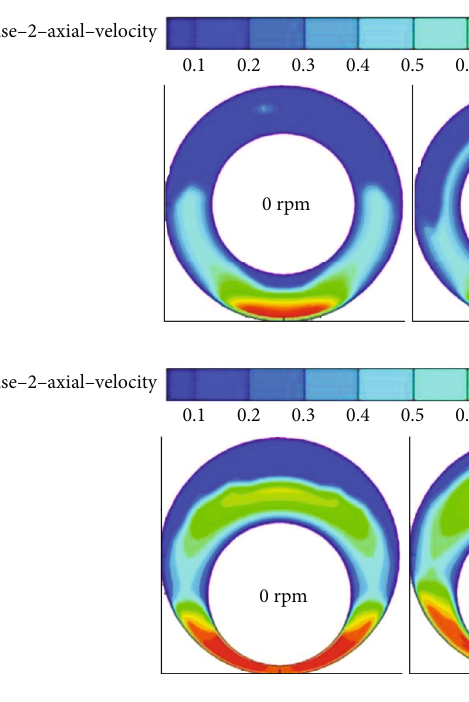
Figure 4: Cloud chart of cuttings migration velocity distribution under di ff erent rotational